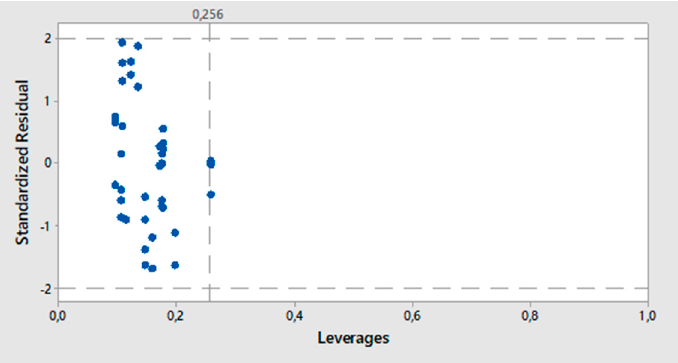
Figure 10. PLS residual vs. leverage plot—E u 50 .